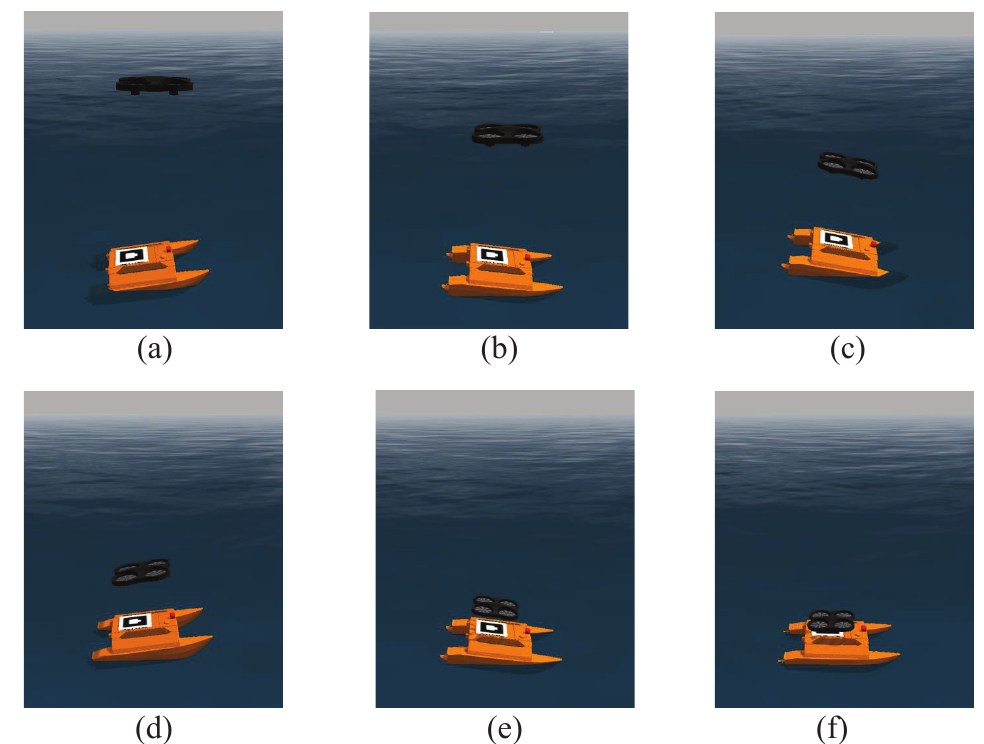
Figure 10. UAV landing autonomously on USV, affected only by USV pitching motion. The UAV altitude does not reach the altitude threshold h 1 (set to 2 m), the UAV continues to descend in altitude ( a , b ); the UAV altitude is less than the altitude threshold h 1, the UAV and the USV attitude remain synchronized ( c , d ); the UAV altitude is less than the altitude threshold h 2 (set to 0.2 m),